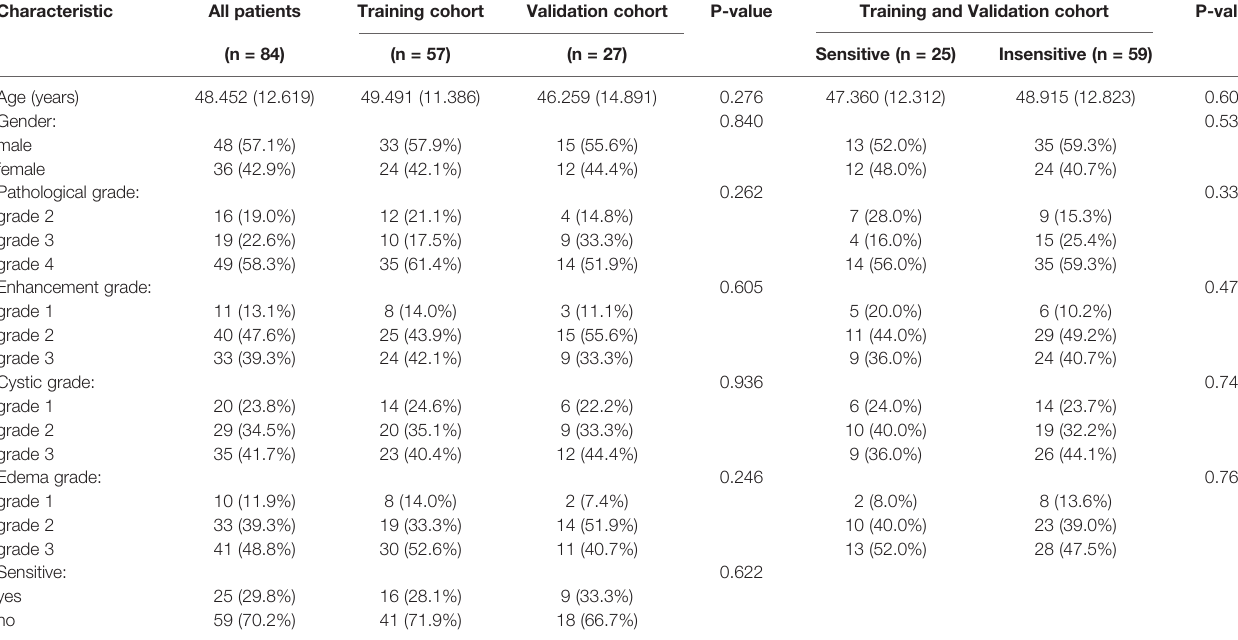
TABLE 1 | Clinical characteristics of the patients and semantic image features in the training and validation cohorts.